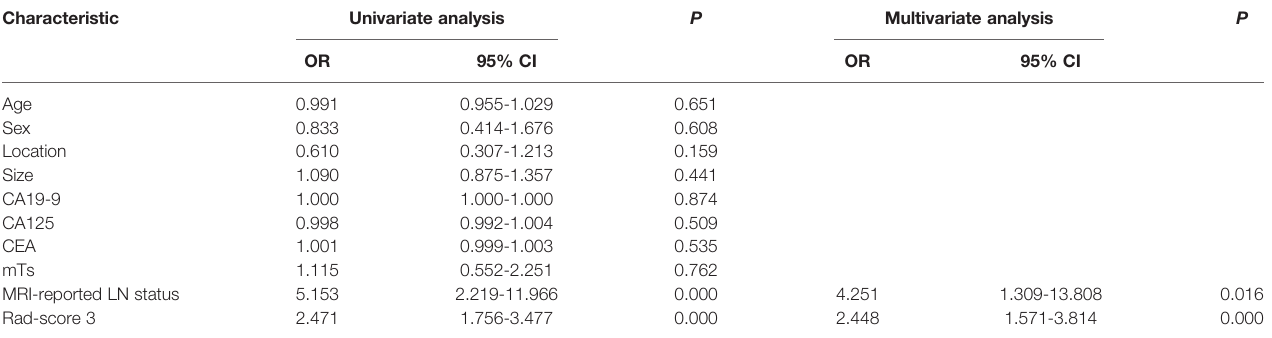
TABLE 4 | Univariate and multivariate logistic regression analyses of the clinical parameters and rad-scores.